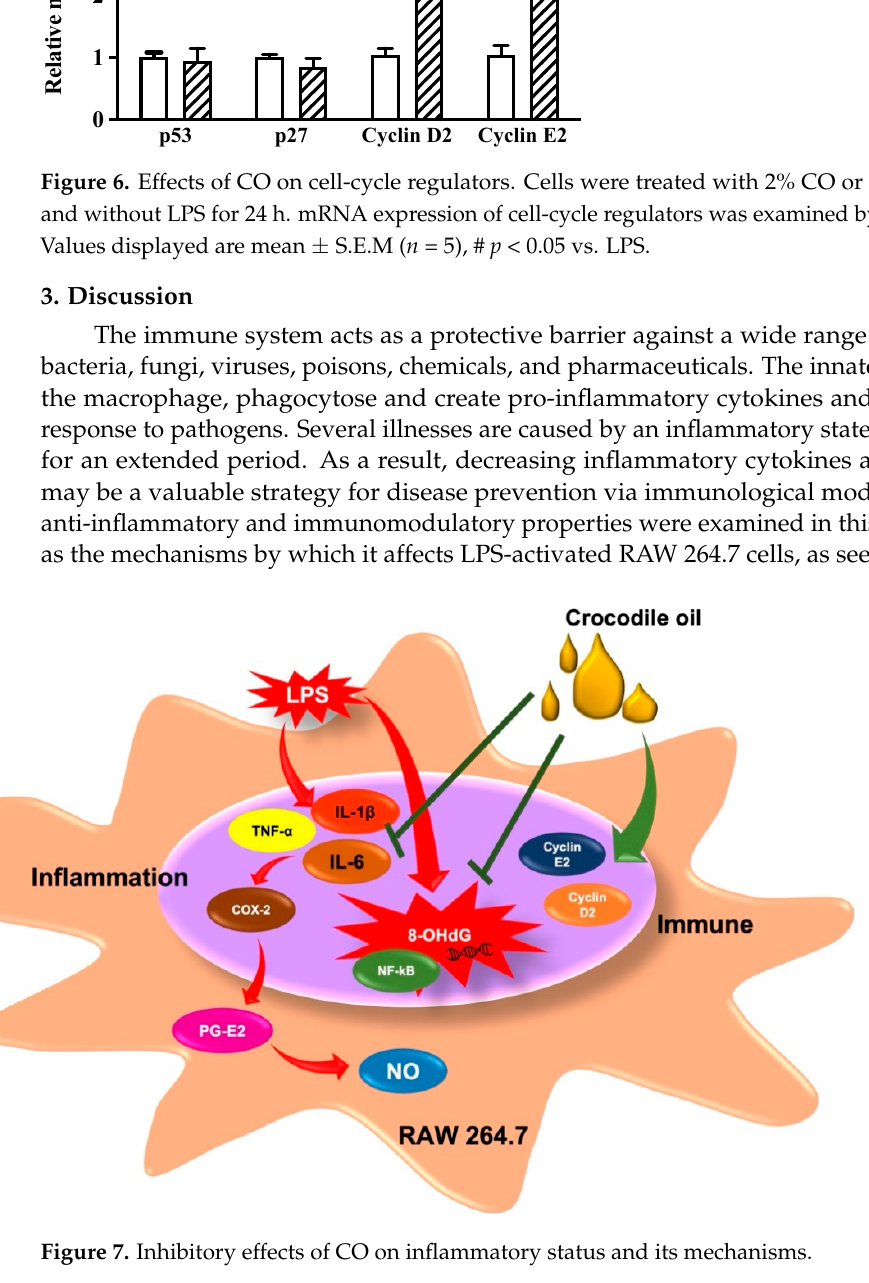
7 of 13 Figure 5. Effects of CO on DNA damage. Cells were treated with 2% CO or 10 µM CX with or with- out LPS. After 24 h, concentration of 8 − OHdG was evaluated using an ELISA kit. Values displayed are mean ± S.E.M ( n = 5), * p < 0.05 vs. control and # p < 0.05 vs. LPS. 2.7. CO Triggers an Immunological Response in LPS-Stimulated Cells To determine the effects of CO on immunological responses, the cell-cycle regulator gene expression was evaluated by qPCR. The results show no significant changes between